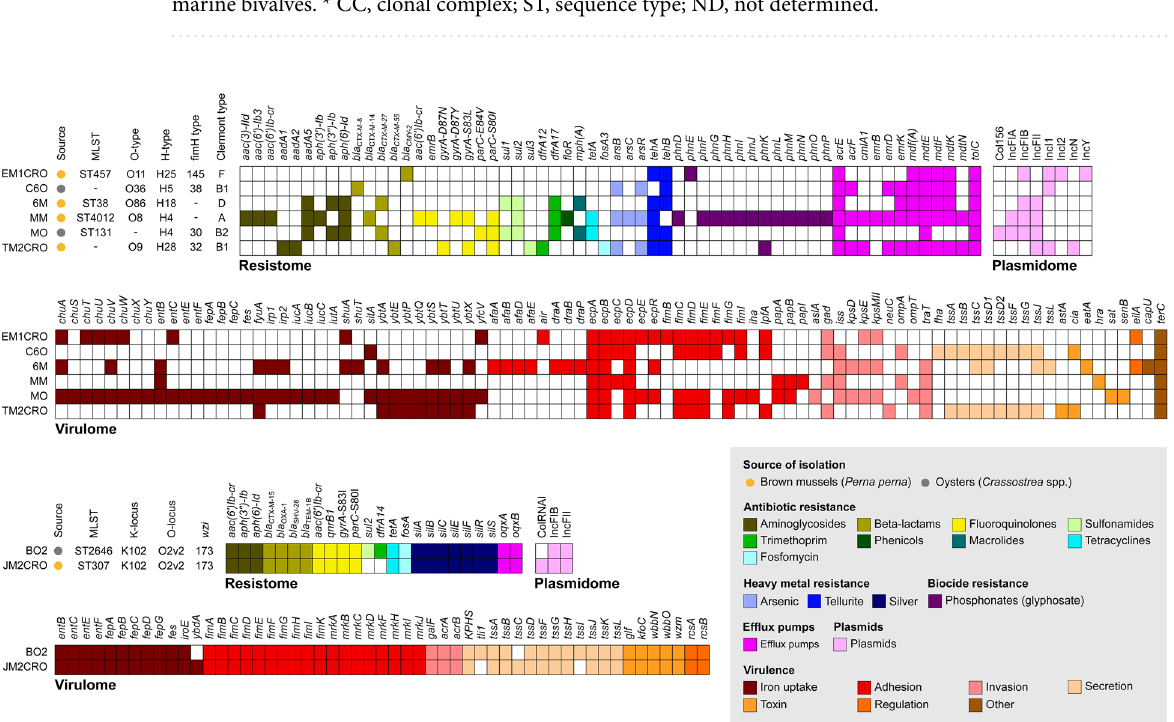
Table 1. Epidemiological characteristics of critical priority WHO Enterobacterales strains isolated from edible marine bivalves. * CC, clonal complex; ST, sequence type; ND, not determined.